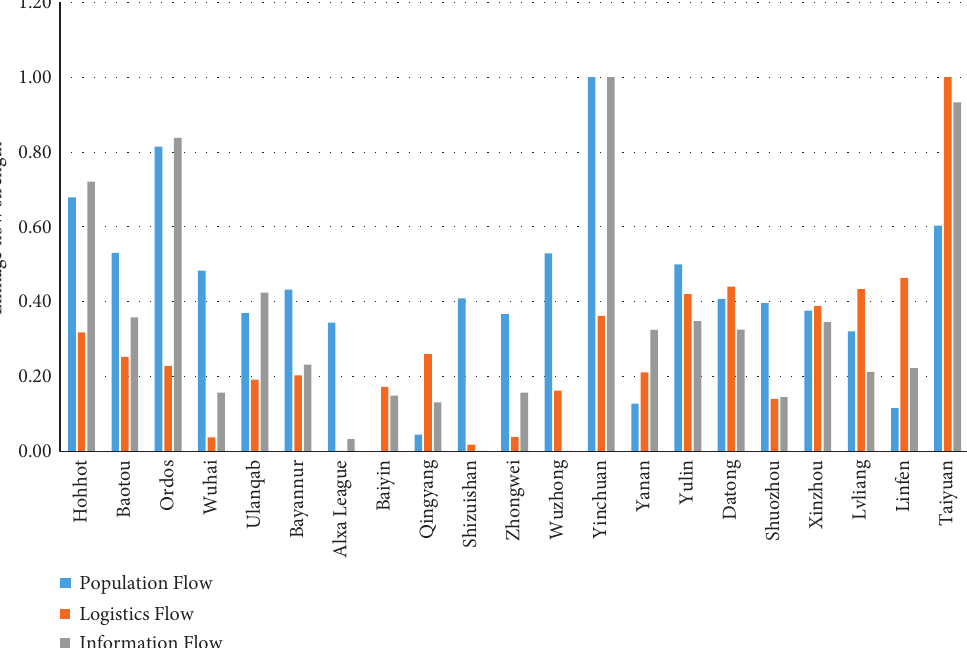
Figure 3: The linkage flow strengths of the three flows for each city in the